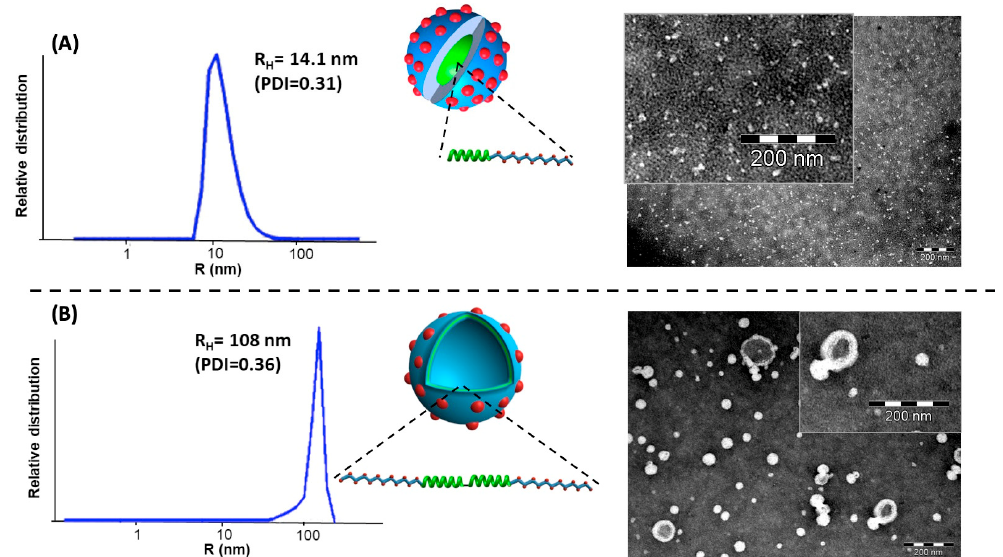
Figure 4. The spherical morphologies obtained upon direct hydration of the diblock and the triblock nucleobase-containing copolymers. ( A ) Very small polymeric micelles based on PBLG- b -PPLGNu diblock copolypeptides. ( B ) Vesicles based on PPLGNu- b -PBLG- b -PPLGNu triblock copolypeptides (Drawings: red dots depict the T nucleobase; R H : hydrodynamic radius; PDI: size distribution of nanoparticles, calculated using the second-order cumulant analysis).